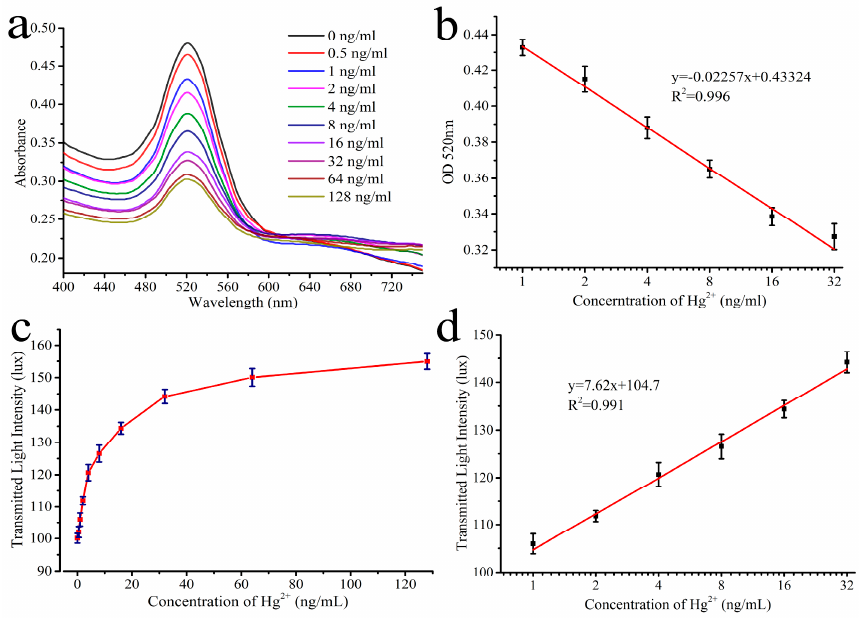
Figure 4. The performance of the MR S-phone system for detection of Hg 2+ in water. ( a ) UV-vis spectroscopy based on the colorimetric detection of different concentrations of Hg 2+ ; ( b ) Calibration curve of colorimetric assay for detecting Hg 2+ using the intensity of the 520 nm peak; ( c ) Transmitted light intensity of the MR S-phone system with different concentrations of Hg 2+ ; ( d ) The calibration curve of the MR S-phone system for detection of Hg 2+ . Each value represents the mean of three independent experiments (n = 3).